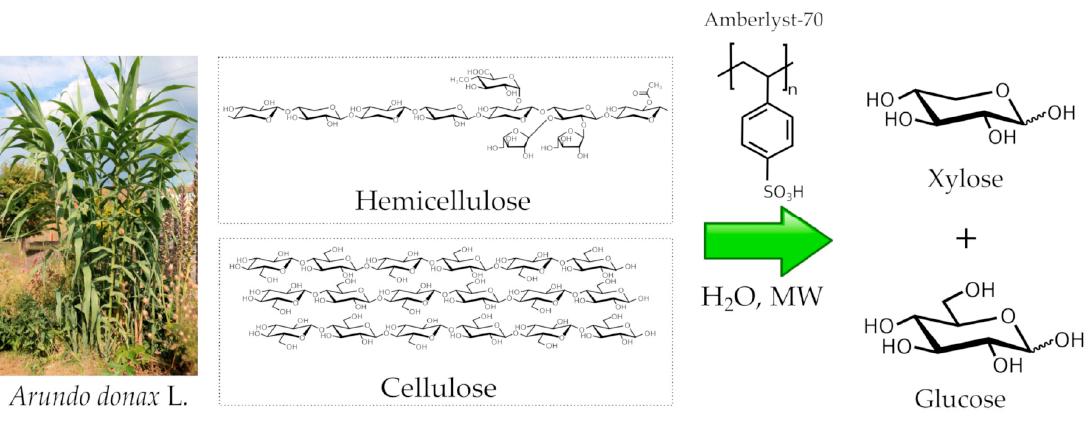
Figure 1. Amberlyst-70 catalysed conversion of the hemicellulose and cellulose fractions of the Arundo donax L. to xylose and glucose,